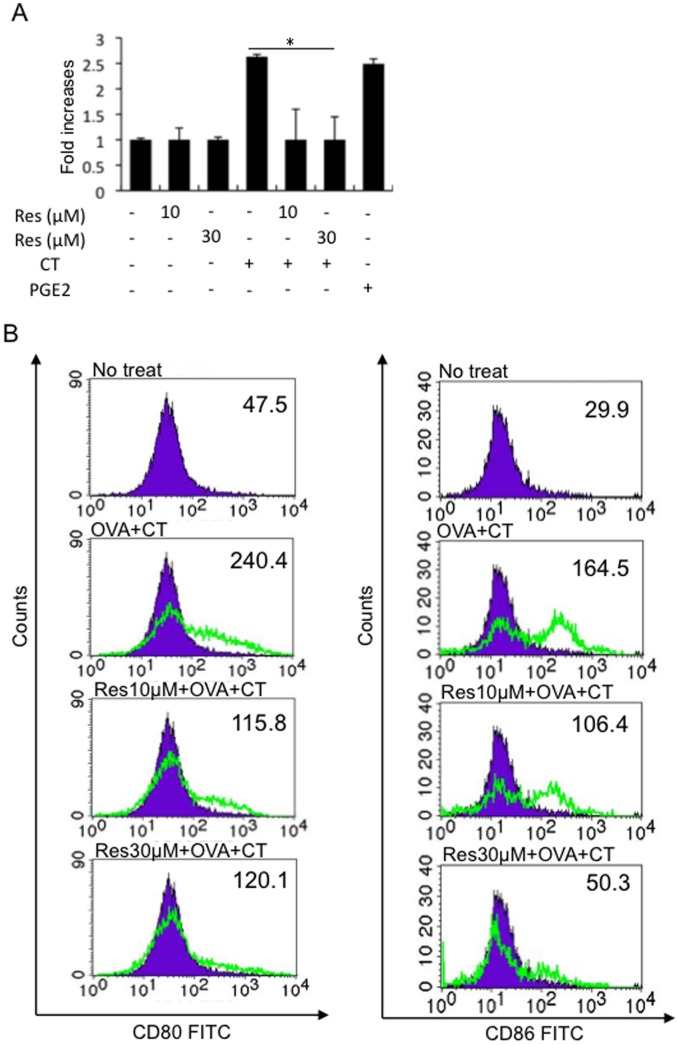
Resveratrol inhibits CT-induced cAMP elevation in BMDCs.A. Cultured BMDCs were un-stimulated or stimulated with 12 pM CT in the presence or absence of 10 or 30 µM resveratrol for 1 hour or 10 nM PGE2 (as a positive control) and intracellular cAMP levels were measured using a cAMP EIA kit. Relative changes in intracellular cAMP levels are indicated. Values represent the mean ± SD (n = 3 per group). B. Cultured BMDCs were un-stimulated (no treat) or stimulated with 300 µg/ml OVA plus 12 pM CT and were cultured in the presence or absence of 10 or 30 µM resveratrol for 3 days. The cells were then stained with APC-conjugated anti-CD11c and FITC-conjugated anti-CD80 or CD86 antibody and were subjected to FACS analysis. A representative histogram regarding surface CD80 and CD86 expression levels on CD11c gated cells is shown. Numbers indicate the mean fluorescence intensity (MFI) of CD80 and CD86-stained cells. The filled histogram indicates un-stimulated (no treat) BMDCs for comparison. Representative results from 3 independent experiments with similar results are shown.